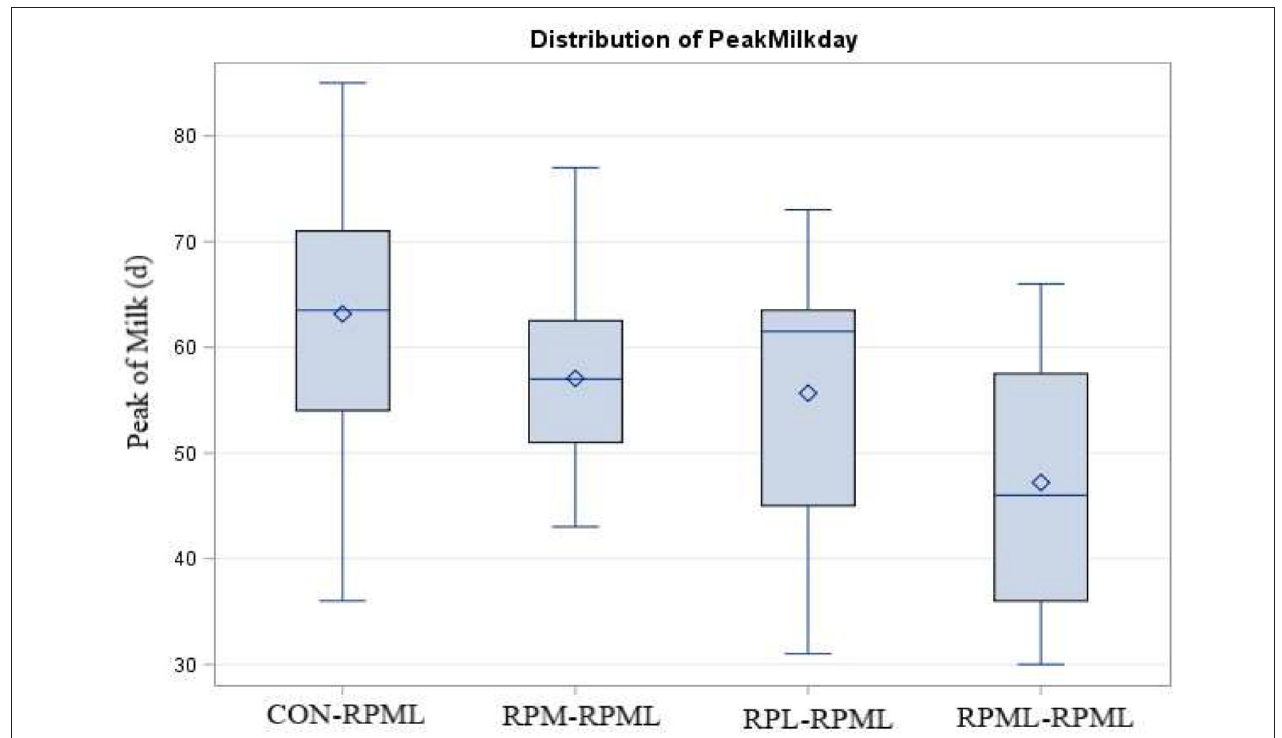
FIGURE 3 | Effect of supply ruminally protected Met and Lys to transition and milking dairy cows on the peak of milk production in days. Values are means; standard errors are represented by vertical